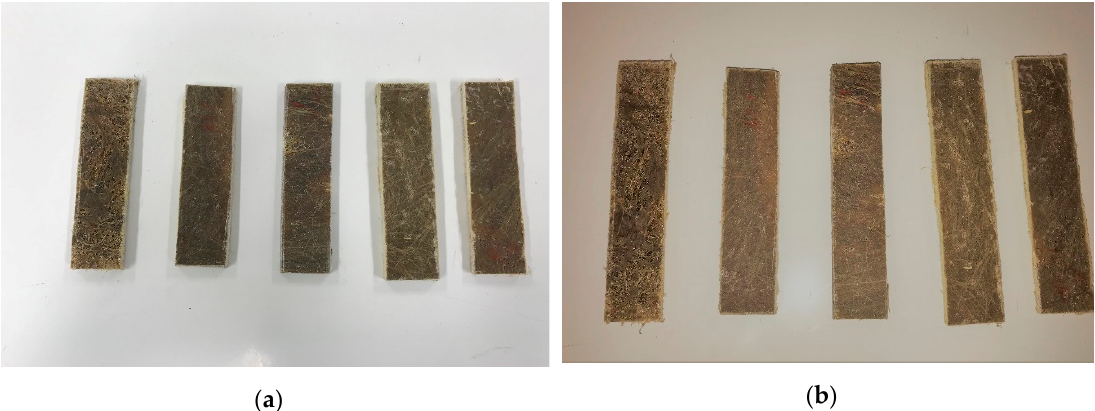
Figure 3. Hemp and flax fiber hybrid composites ( a ); banana and pineapple fiber hybrid composites ( b ).